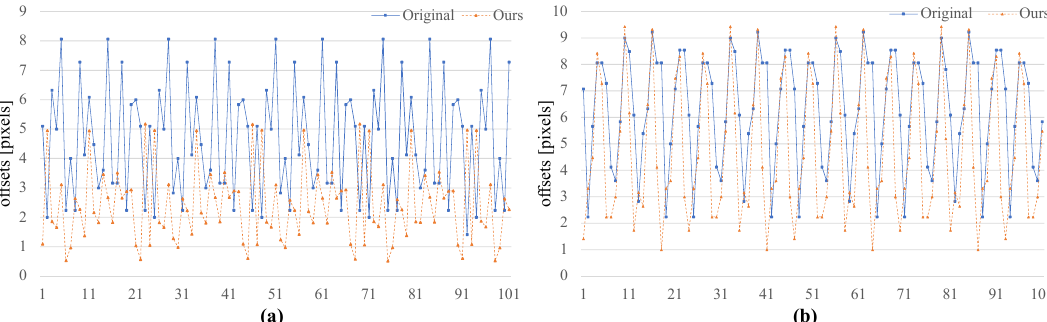
Figure 14. Difference between detected and real location of object in the two evaluated algorithms. ( a ) at low object speed; ( b ) at high object speed.